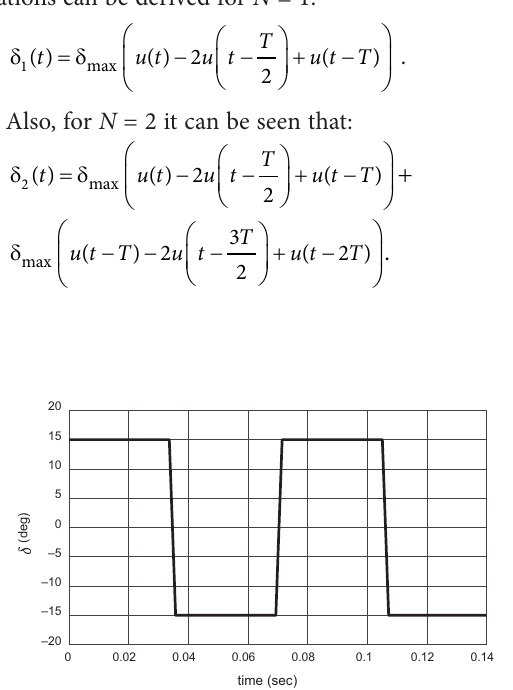
Figure 2. Time history of ideal ON-OFF actuator